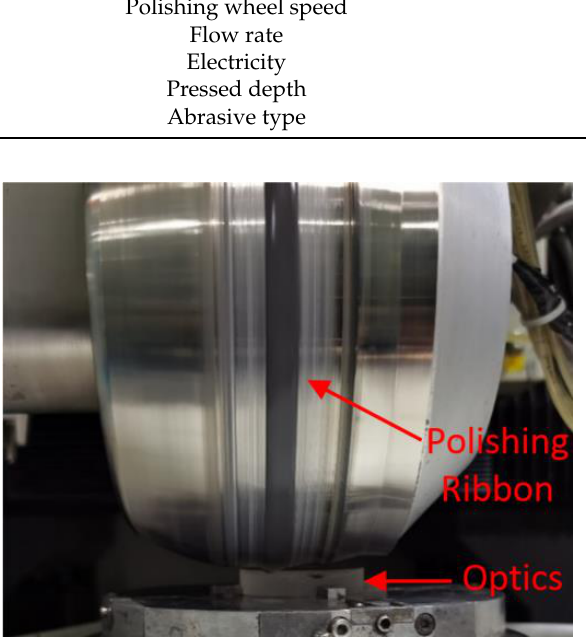
Figure 4. MRF polishing device.